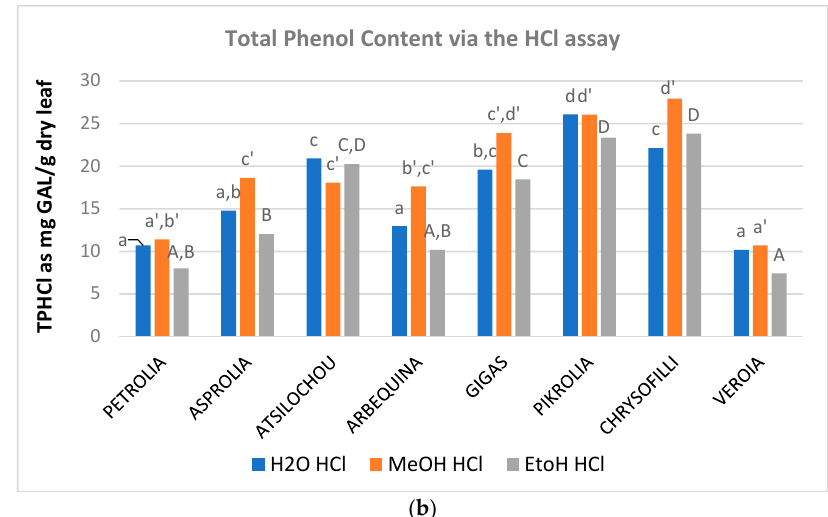
Figure 2. Total phenol content of OLF polar (aqueous, methanol, and ethanol) extracts as determined via the ( a ) Folin–Ciocalteu (TPFC) and ( b ) spectrophotometric by Obied et al. [22] assay (TPHCl); different letters (a–d, a’–f’, A–F) indicate statistical significant differences.